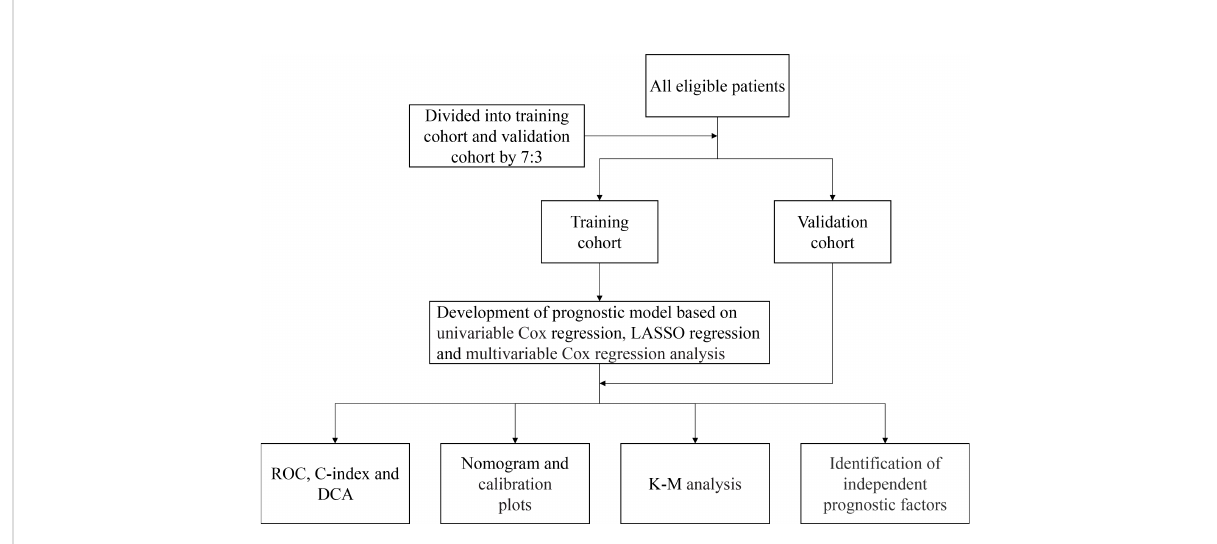
FIGURE 1 The fl ow diagram of the